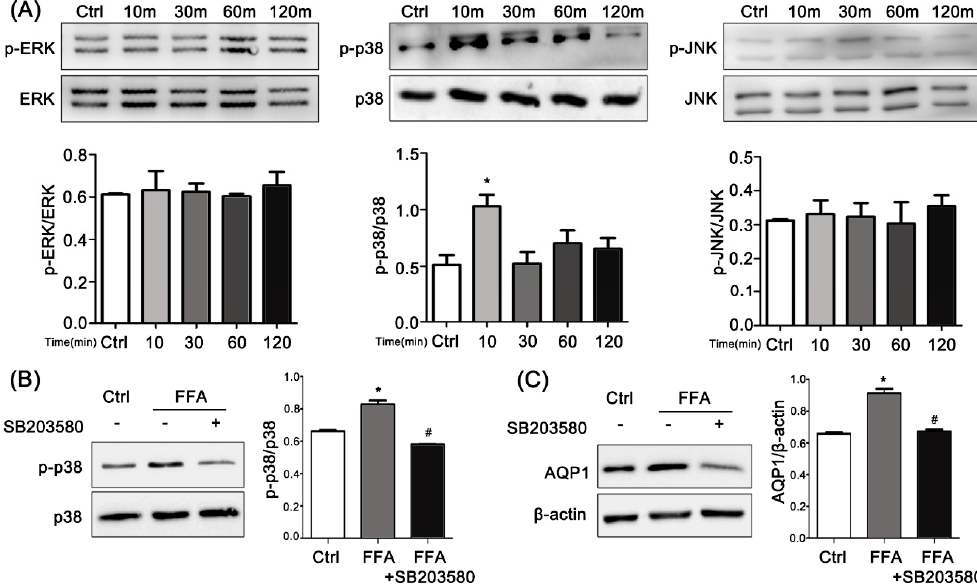
Figure 4. Activation of phosphorylation of MAPK by FFAs and effects of p38 inhibition on FFA-induced up-regulation of AQP1 in PMVECs. ( A ) Western blot analysis of p-ERK, p-p38 kinase, p-JNK expression in PMVECs stimulated by FFAs. P-p38 kinase was significantly activated; ( B ) SB203580 was confirmed to inhibit the expression of p-p38 kinase in PMVECs stimulated by FFAs; ( C ) Expression of AQP1 was reduced by SB203080 in PMVECs stimulated by FFAs. * p < 0.05, the statistics were made by comparing with Ctrl group, respectively. # p < 0.05, the statistics were made by comparing with FES group.